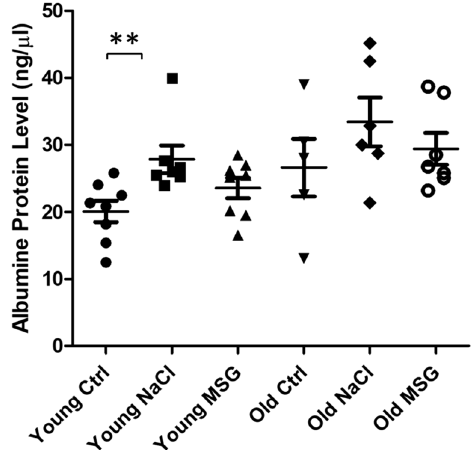
Figure 1. Albuminuria in male mice at the end of treatment. Albumin excretion was evaluated with silver staining. Urinary samples obtained from 6 and 18 months old mice, whose diet was supplemented for 2 months with water, sodium chloride or MSG (Ctrl, NaCl and MSG, respectively), were examined. N = 8 (young Ctrl), 7 (young NaCl), 8 (young MSG), 5 (old Ctrl), 6 (old NaCl), 7 (old MSG). Mann–Whitney test ** p <